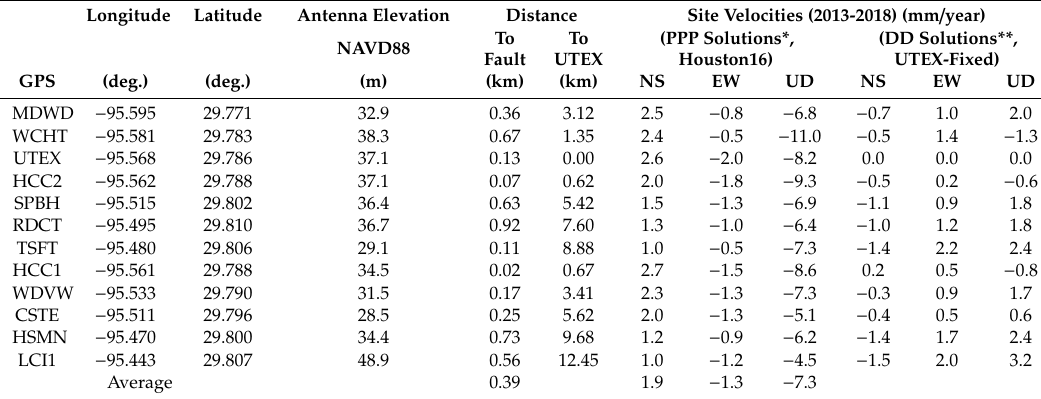
Table 1. Major parameters of the Long Point Fault GPS Array